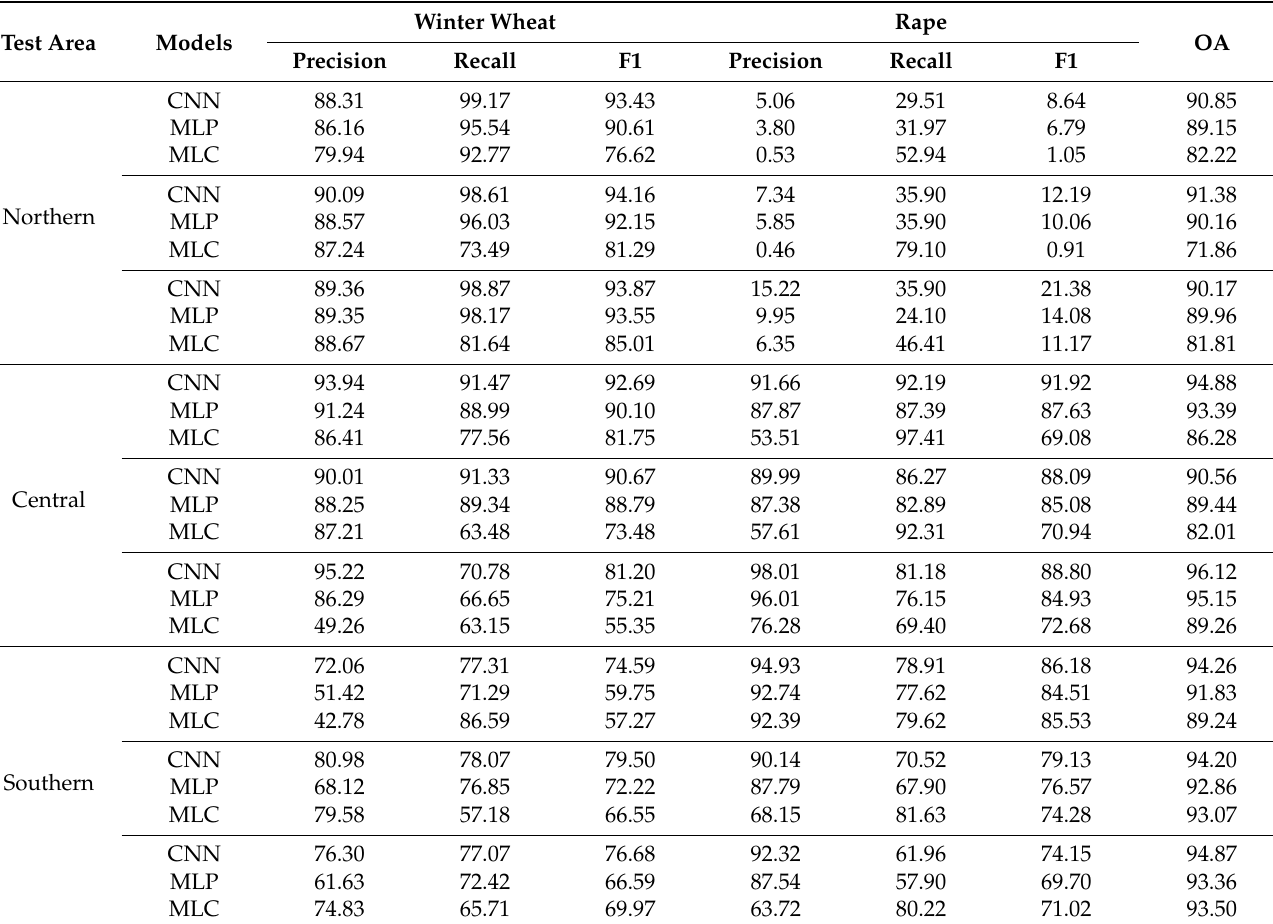
Table 15. Results of the correlation method to identify winter wheat on